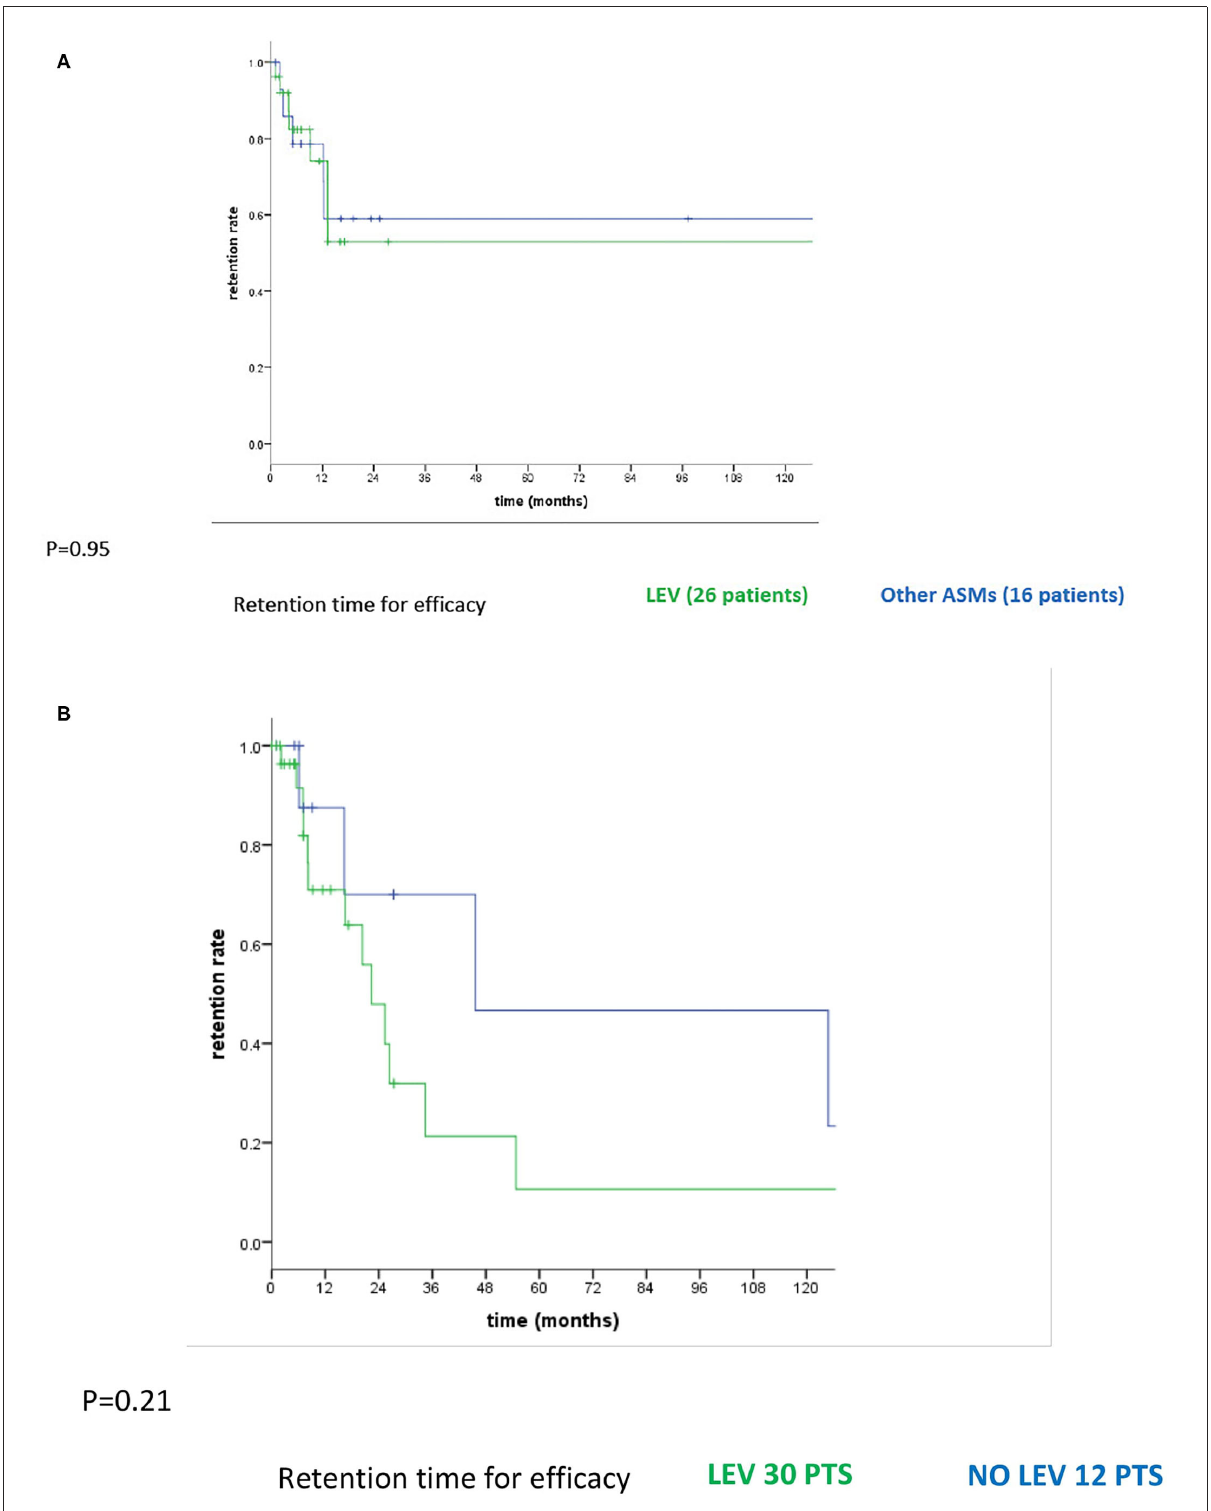
FIGURE1 (A) Cumulative time-dependent probability of remaining on the first assigned ASM for the lack of efficacy between LEV and other ASMs. (B) Cumulative time-dependent probability of remaining on assigned ASM therapy for the lack of efficacy between LEV-based therapy and other ASMs after the first change due to